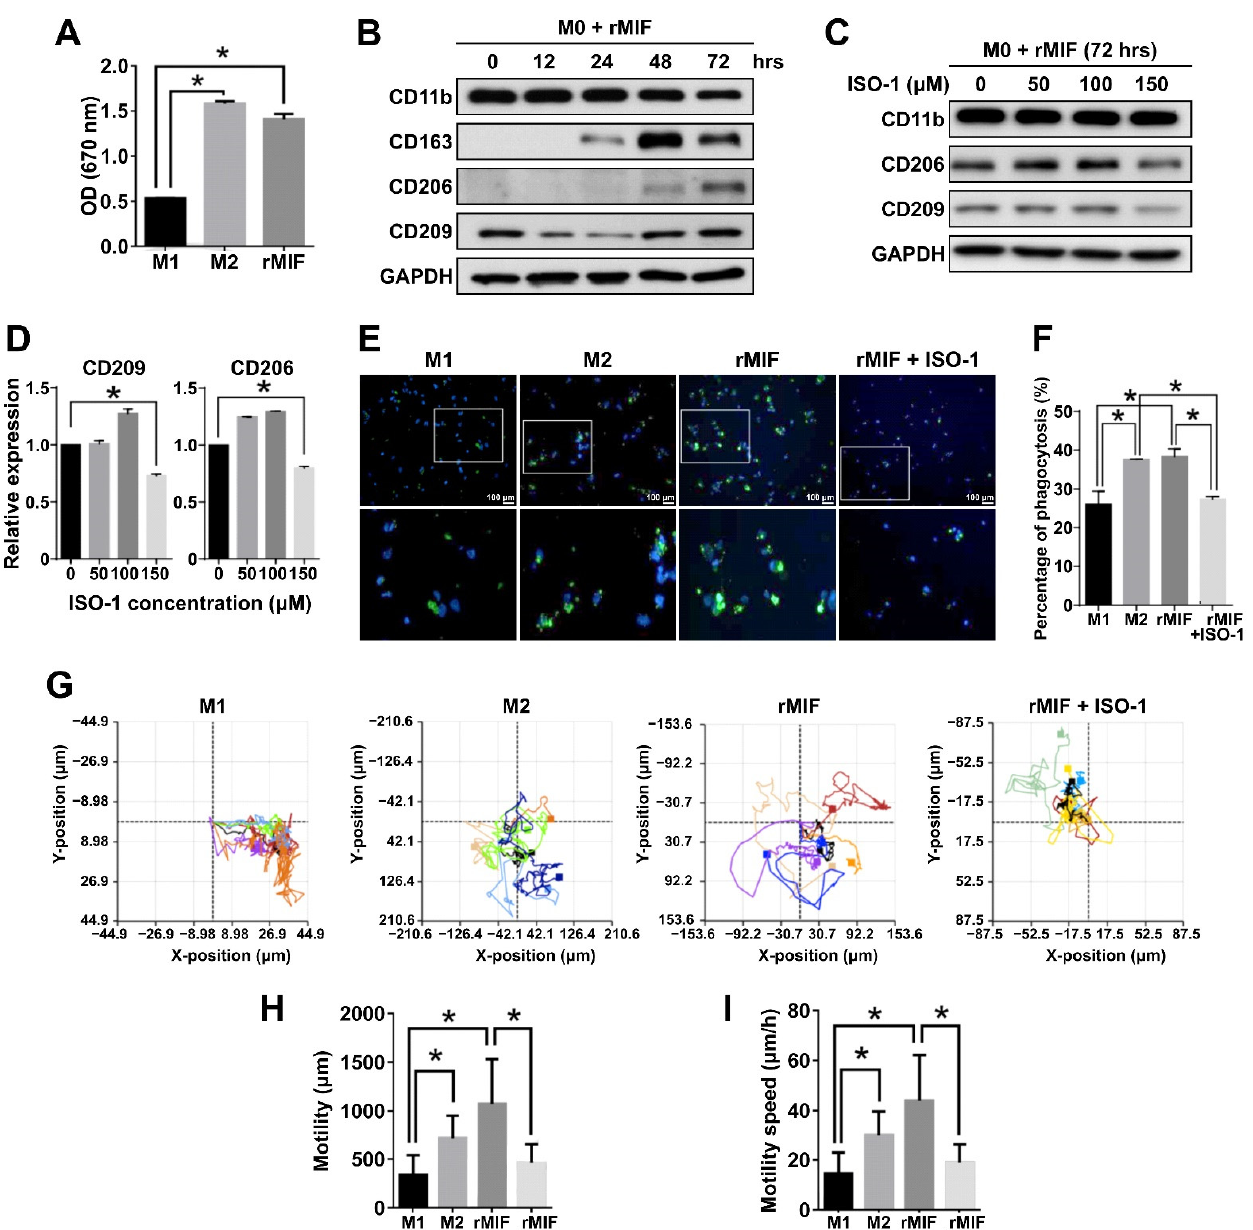
Figure 4. MIF1 antagonist ISO-1 is effective in reducing the M2 subpopulation and cellular proliferation, migration and phagocytosis. ( A ) MTT proliferation assay showing the effect of rMIF on proliferation of the rMIF-induced M0 phagocytes as compared to the M1 and M2 phagocytes derived by standard protocols. Mean values are shown, n = 3, SD—error bars, * p < 0.05 (Student’s t -test). ( B ) Western blotting showing the expression of the indicated macrophage markers in the time course of treatment of M0 macrophages with 100 ng/mL rMIF. GAPDH—loading control. ( C ) Western blotting analysis of the expression of the indicated markers in the cells derived by treatment of M0 macrophages with rMIF for 72 h in the absence (0 μ M) or presence of ISO-1 at the indicated concentrations. ( D ) Densitometry quantification of the expression of CD209 and CD206 shown by Western blotting in ( C ). Mean values relative to 0 μ M ISO-1 are shown, n = 3, SD—error bars, * p < 0.05. ( E ) Fluorescence microscopy images showing phagocytotic cells (green fluorescence) among the indicated mac- rophages. The bottom panel shows a zoomed view of the areas marked by rectangles in the top panel. Nuclei stained with DAPI (blue fluorescence). ( F ) Quantitative analysis showing the percentage of phagocytotic macrophages among the total number of macrophages. Means with SD error bars are shown, n = 3, * p < 0.05 (Student’s t -test). ( G ) Single-cell tracking by time-lapse microscopy of the indicated groups of macrophages. ( H,I ) Quantification of motility ( H ) and motility speed